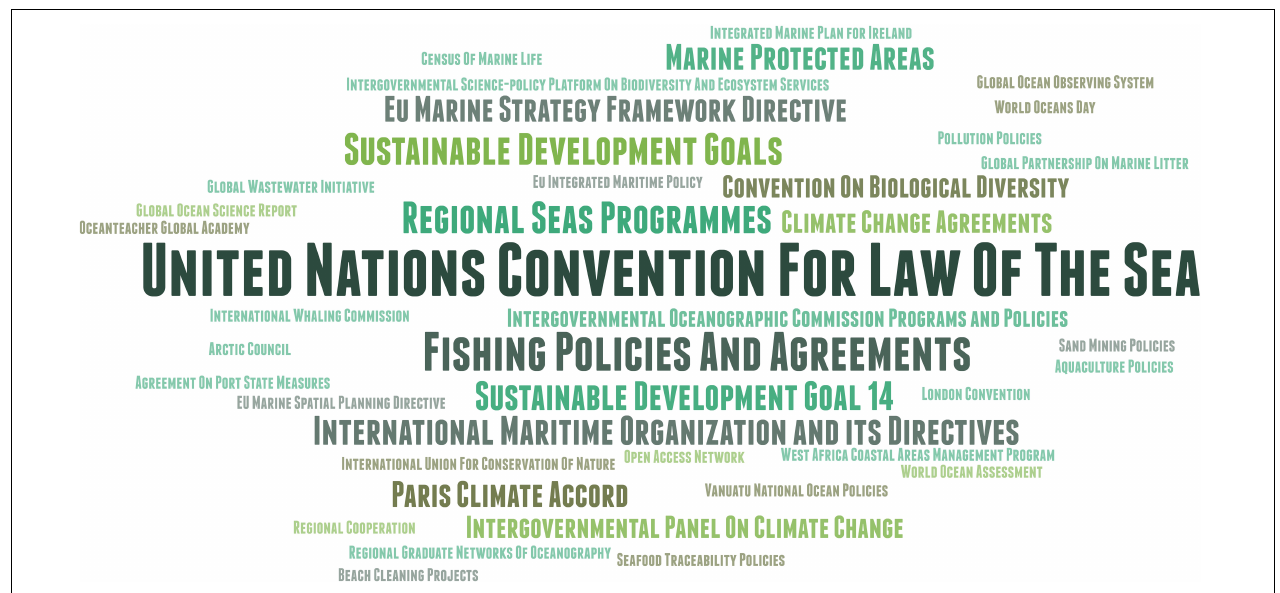
FIGURE 6 | A word cloud depicting the relative number of references to international ocean policy influences mentioned by survey respondents. The size of each policy influencer in the cloud is proportional to the number of times that political influencer was mentioned by survey respondents (Powered by WordArt.com).